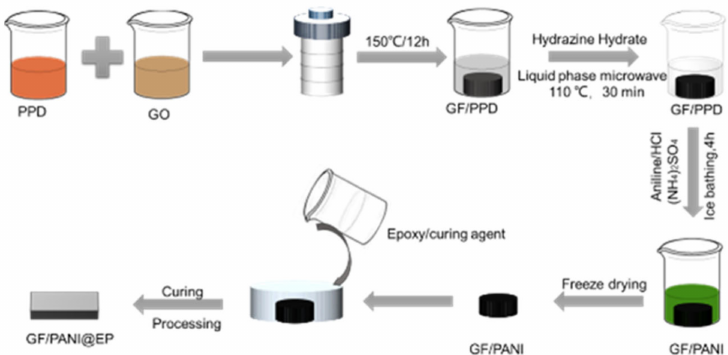
Figure 1. Schematic diagram of the fabrication for PPD modified GO/polyaniline @ EP thermal interface